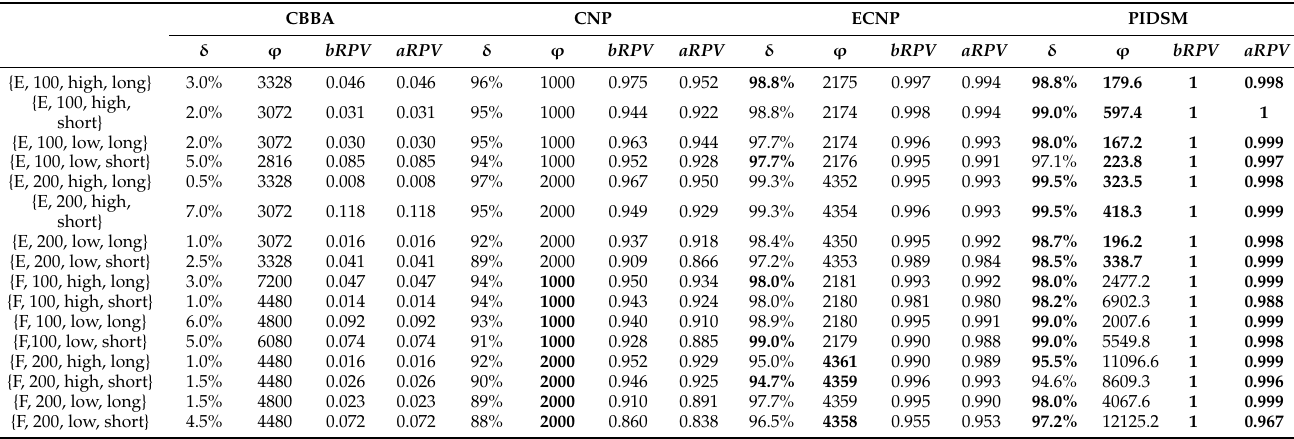
Table 7. The comparison results for large-type